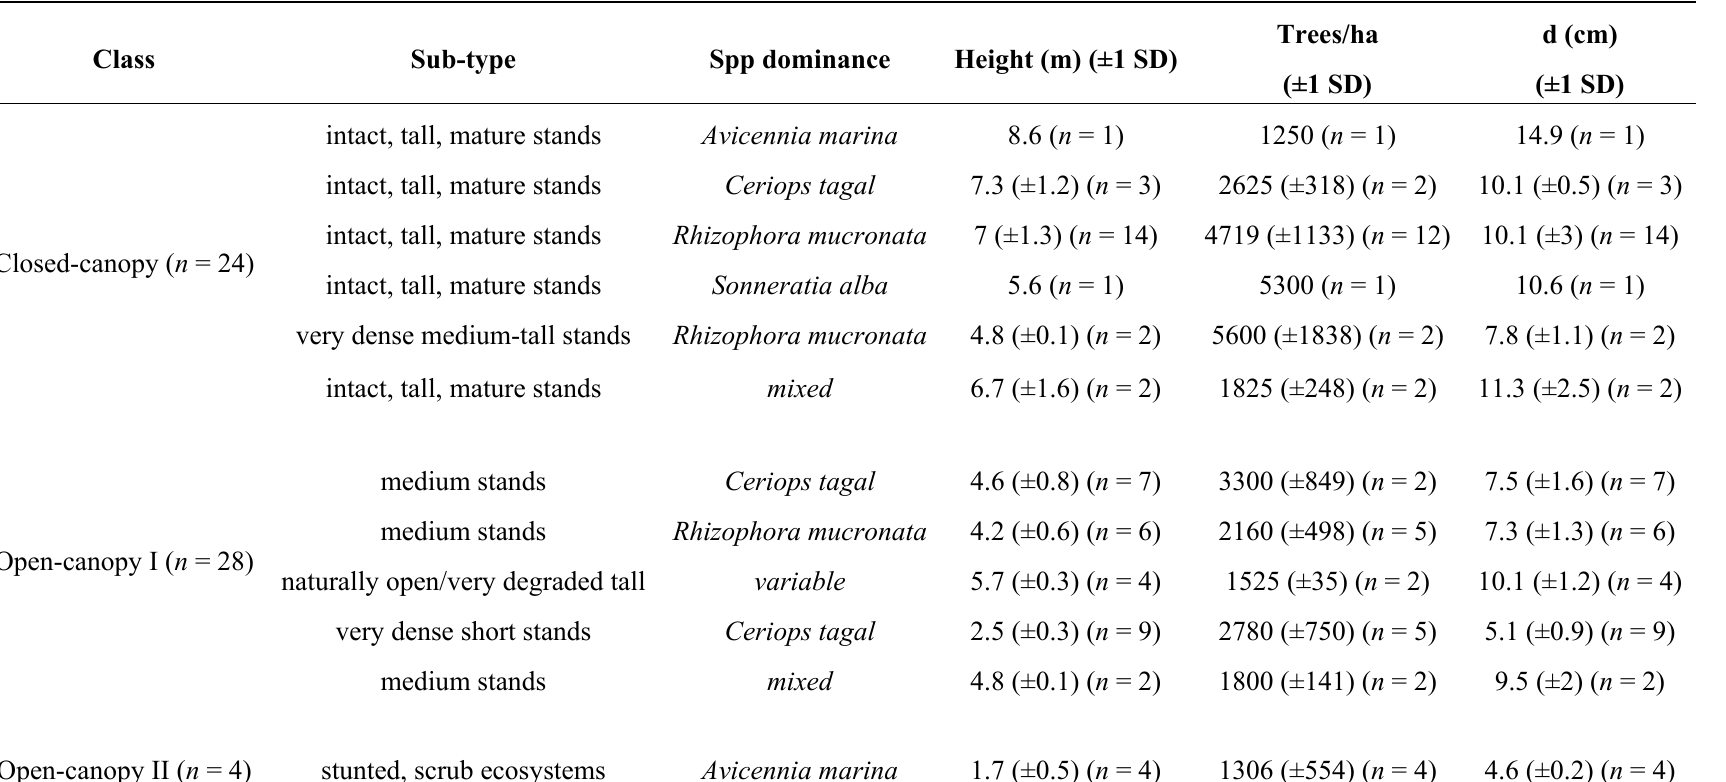
Table 4. Class sub-type, species (spp) dominance, average height in meters (m) (±1 standard deviation (SD)), average trees per hectare (ha) (±1 SD) and average diameter (d) in centimetres (cm) (±1 SD). Trees/ha ( i.e. , density) calculated for intact plots. N represents plots per class